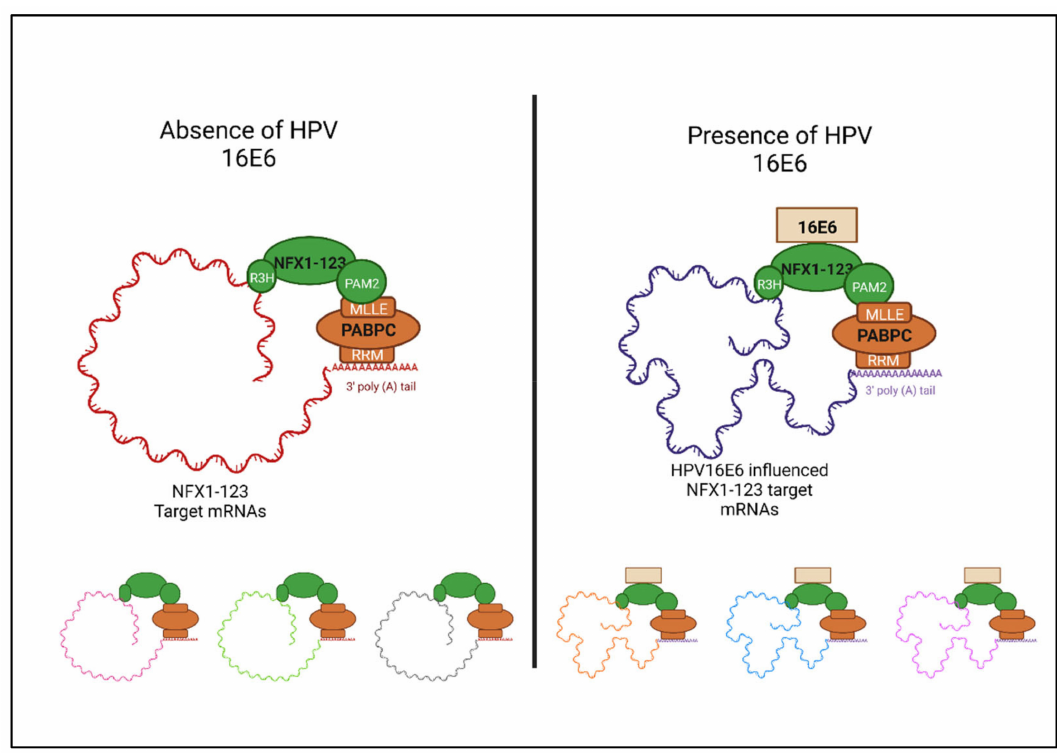
Figure 4. Schematic of influence of HPV 16E6 in partnership with NFX1-123. NFX1-123 has the capabilities to bind to mRNA both directly and indirectly. The R3H domain of NFX1-123 contains putative mRNA binding capabilities, which enable NFX1-123 to bind directly to the target transcript. The PAM2 motif of NFX1-123 binds to PABPCs at the MLLE domain. PABPCs can bind to the poly (A) tail of mRNA and help prevent deadenylation of the transcript. The binding to PABPCs allows NFX1-123 to indirectly bind to target mRNAs, which allows for increased stability of the transcripts. In the presence of HPV 16E6, this mRNA signature of NFX1-123 targets shifts. There are different pools of mRNAs that NFX1-123 binds to with or without 16E6, which are represented by the smaller complexes at the bottom of the figure. Figure created with